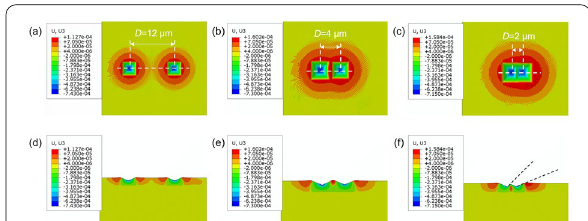
Figure 6 Top views of the simulated results for the two adjacent indentations with the rotation angle of 45° and the spacings of a 12 μm, b 4 μm and c 2 μm; Side views of the simulated results for the two adjacent indentations with the rotation angle of 45° and the